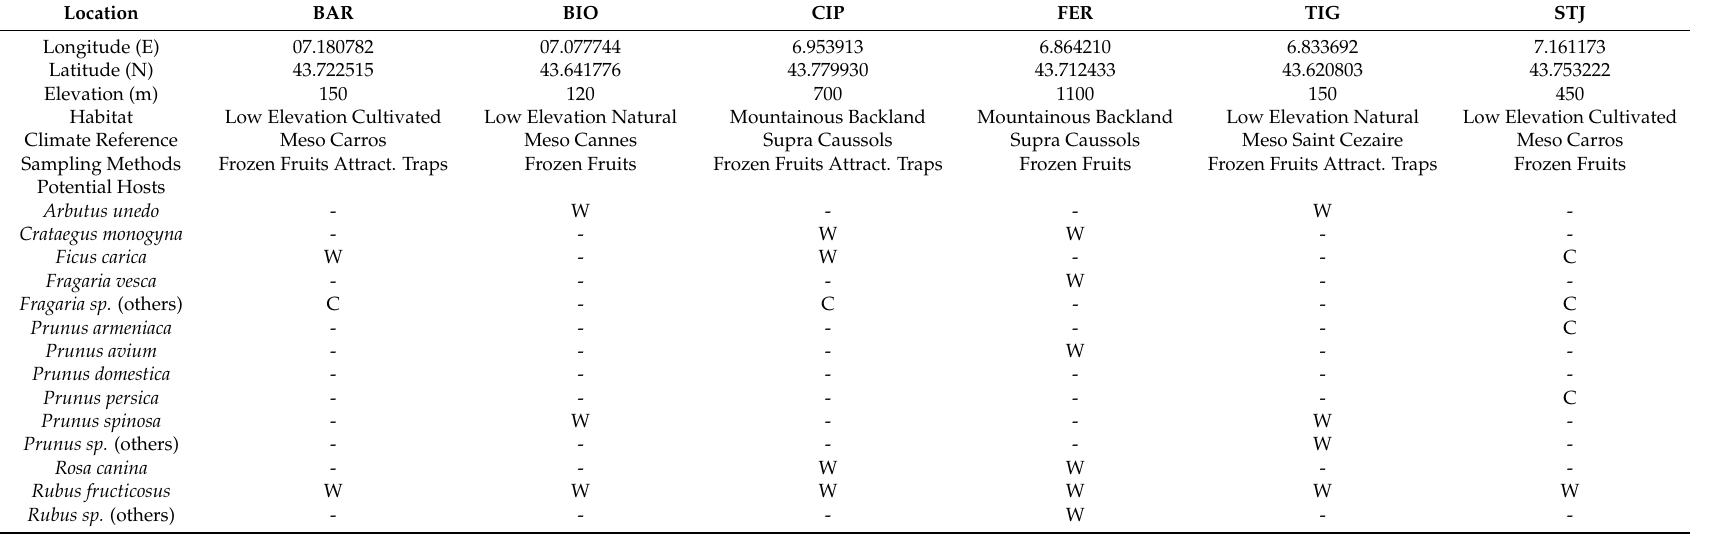
Table 1. Description of the six trapping locations including geographic, climatic, and ecological information, Information on the four climatic references (Cannes, Carros, Caussols, and Saint Cezaire) are provided in the Supplementary Material Table S1. Potential host plants of D. suzukii have been defined according to